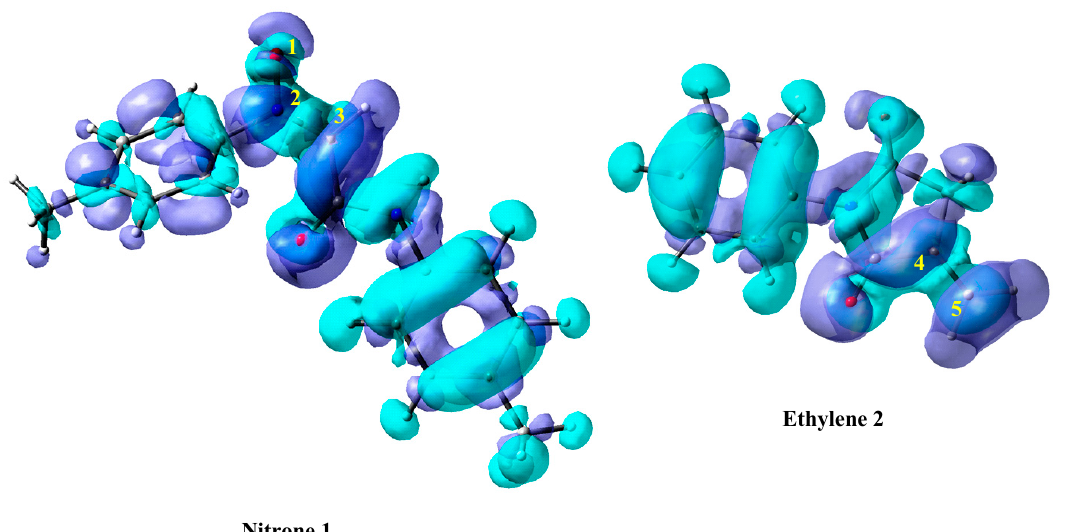
Figure 2. Maps of Δ f ( r ) dual descriptors for nitrone 1 and ethylene 2 with isovalue = 0.006. Figure 2. Maps of ∆ f ( r ) dual descriptors for nitrone 1 and ethylene 2 with isovalue = 0.006.